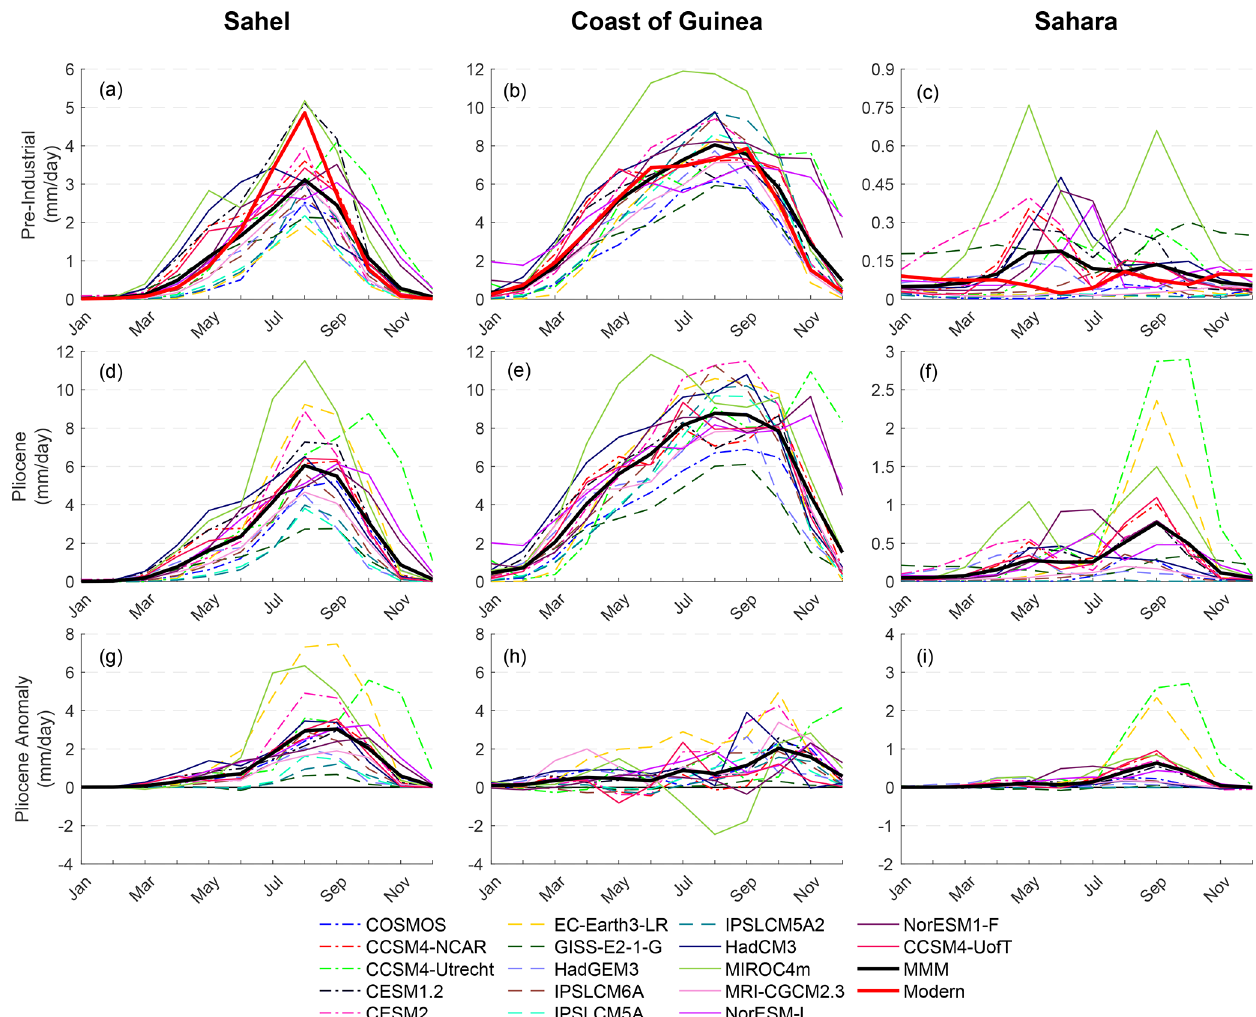
Figure 1. Seasonal cycle of rainfall (unit:mm/d) over the Sahel (a, d, g) , the coast of Guinea (b, e, h) , and the Sahara region (c, f, i) for PI (a–c) , mPWP (d–f) , and mPWP anomalies (mPWP-PI, g–i ). The multi-model mean MMM (black) is shown together with the individual models, and the modern conditions as derived from observations (Harris et al., 2020) are included as a reference